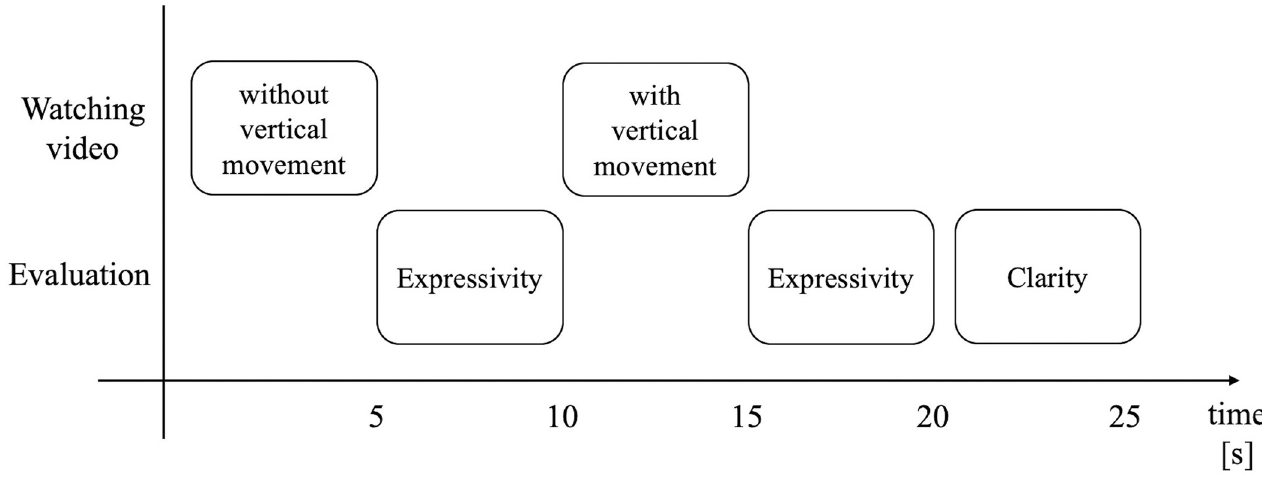
Fig 5. Procedure of the experiment. After watching the first video, the participants evaluated the expressivity of emotions of the robot in the video. Then, they watched the second video and evaluated the expressivity as well as the clarity of emotions of the robot in the video.